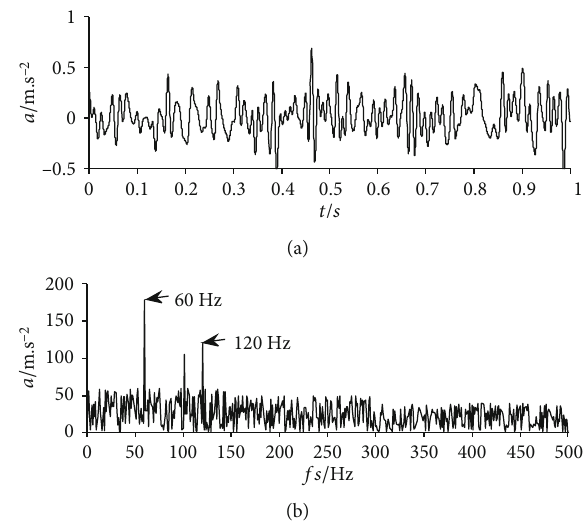
Figure 3: Waveform and frequency spectrum of simulated signal denoised by traditional morphological fi lter with small-scale structuring elements. (a) Waveform. (b) Frequency spectrum.